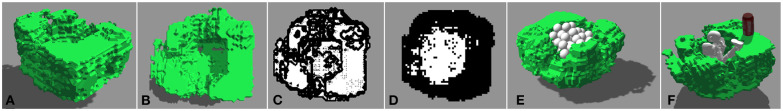
The generated object with contain-ability and support-ability (similar to a bathtub-workdesk, or bathdesk) in (A) perspective view and (B) top-down view. (C) Result of the support-ability test: white pixels show locations with support-ability. (D) Contain-ability map. (E) Still frame from the contain-ability test with spheres. (F) Demonstration that the workdesk-bathtub can fit an iCub humanoid robot, and support a tin can.